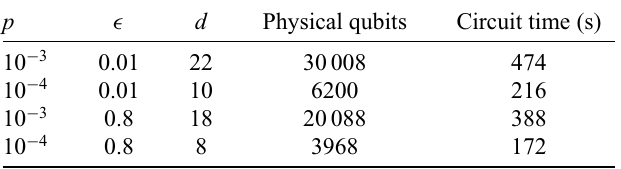
TABLE I. Error-corrected resource estimates for simulations of the 11-qubit CaF 2 + μ + system with 40 second-order Trotter steps. Here, p is the physical error rate, (cid:14) is the expected number of errors per circuit, and d is the surface-code distance